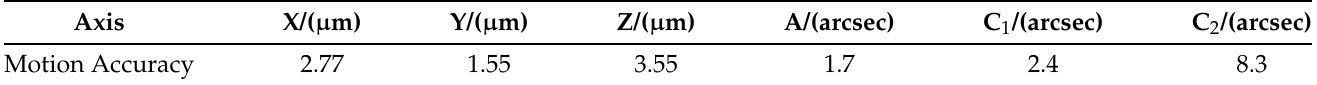
Table 1. Motion accuracy of each axis.